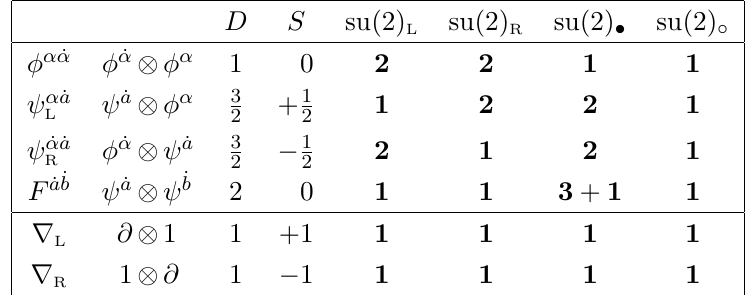
Table 1. Primary fields appearing at the sites of the massive spin chain. The first column gives the various fields, and the second column gives their decomposition under psu(1 , 1 | 2) The rest of the table shows how the fields transform under the bosonic subalgebra as well as under the two extra symmetries su(2) • and su(2) ◦ . The derivatives in the last two lines of the table are not fields but are included to indicate the quantum numbers carried by su(1 , 1) descendants of the fields. Note that the field F ˙ a ˙ b can be decomposed into a triplet and a singlet under su(2) •